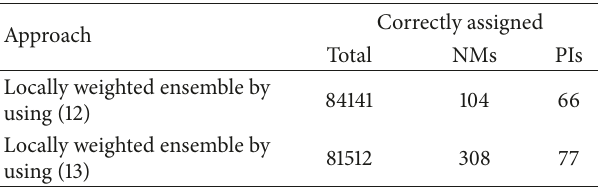
Table 6: Locally weighted ensemble classification results: method using (12) and (13).